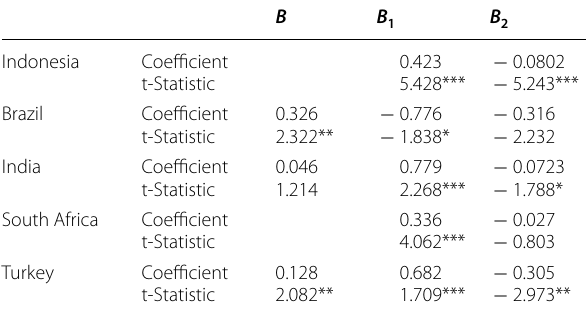
Table 3 Conditional and unconditional FDI growth